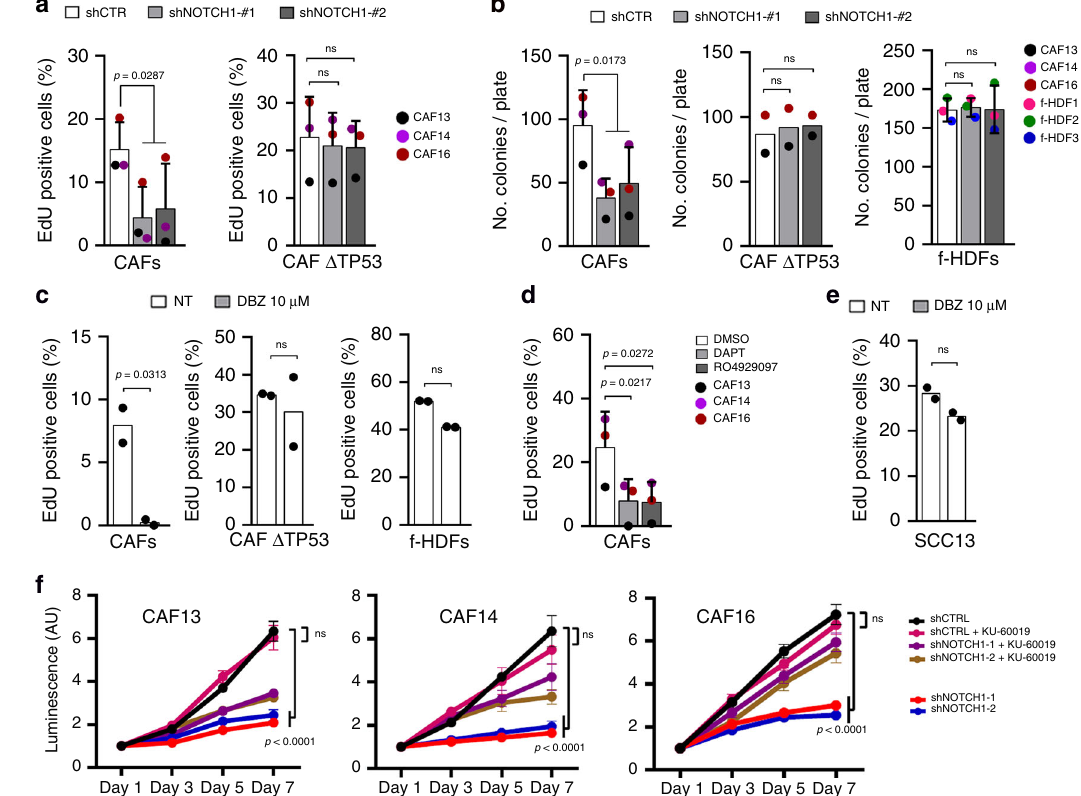
Fig. 7 NOTCH1 silencing or inhibition impair CAFs proliferation. a EdU assays of CAF strains plus/minus NOTCH1 silencing (7 days) and of the same CAF strains with CRISPR-mediated disruption of the TP53 gene (as characterized in Supplementary Fig. 5a, b) plus/minus NOTCH1 silencing (7 days). >196 cells were analyzed per condition. n (CAF strain) = 3, n (CAF CRISPR TP53 strain) = 3. b Clonogenicity assays of CAF strains plus/minus shRNA-mediated NOTCH1 silencing (10 days), of CAF strains with CRISPR-mediated disruption of the TP53 gene plus/minus NOTCH1 silencing (10 days), and of three f-HDF strains plus/minus shRNA-mediated NOTCH1 silencing (10 days). n (technical replicates/condition) = 3, n (CAF strain) = 3, n (f-HDF strain) = 3, and n (CAF CRISPR TP53 strain) = 2. c EdU assays of CAF strains (#13 and 16) plus/minus CRISPR-mediated disruption of TP53 and of f-HDF strains (#5 and 6) after 5 days of treatment with DBZ (10 μ M) versus DMSO vehicle alone. >125 cells were analyzed per condition. n (CAF strain) = 2, n (CAF CRISPR TP53 strain) = 2, and n (f-HDF strain) = 2. d EdU assays of CAF strains plus/minus treatment with the γ -secretase inhibitors DAPT and RO4929097 (10 μ M) versus DMSO vehicle alone for 5 days. >143 cells were analyzed per condition. n (CAF strain) = 3. e EdU assays of SCC13 strain after 5 days of treatment with DBZ (10 μ M) versus DMSO vehicle alone. >317 cells were analyzed per condition. n (SCC13) = 1. a – e Values for each strain are indicated as dots with mean ± s.d. two-tailed unpaired t -test, * p < 0.05. f CellTiter-Glo analysis of CAF strains infected with two NOTCH1 silencing lentiviruses versus empty vector control (for 7 days) plus/minus concomitant treatment with the ATM inhibitor KU-60019 (2 µ M) at the indicated days after viral infection. Results are presented as luminescence intensity values relative to day 1. Data are shown as mean of values in triplicate dishes ±sd. Two-way ANOVA followed by Tukey ’ s multiple comparisons test, **** p < 0.0001. n (CAF strain) =